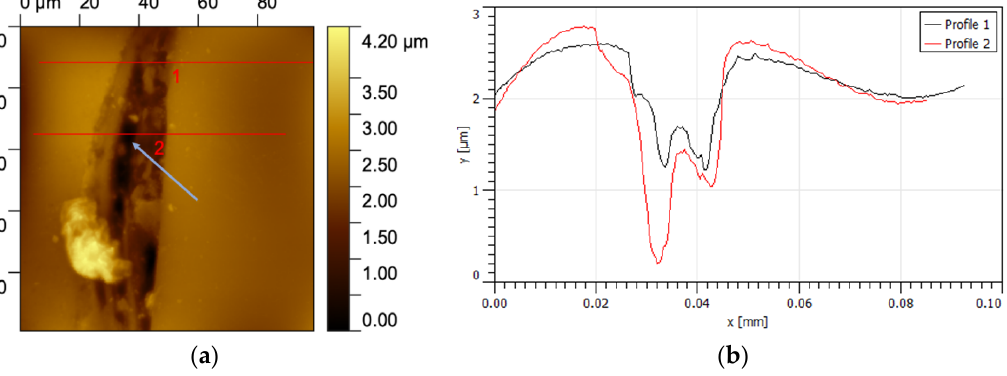
Figure 22. AFM image of the HTS tape sample subjected to surge currents along with the cross-section in the place marked with red lines 1 and 2.